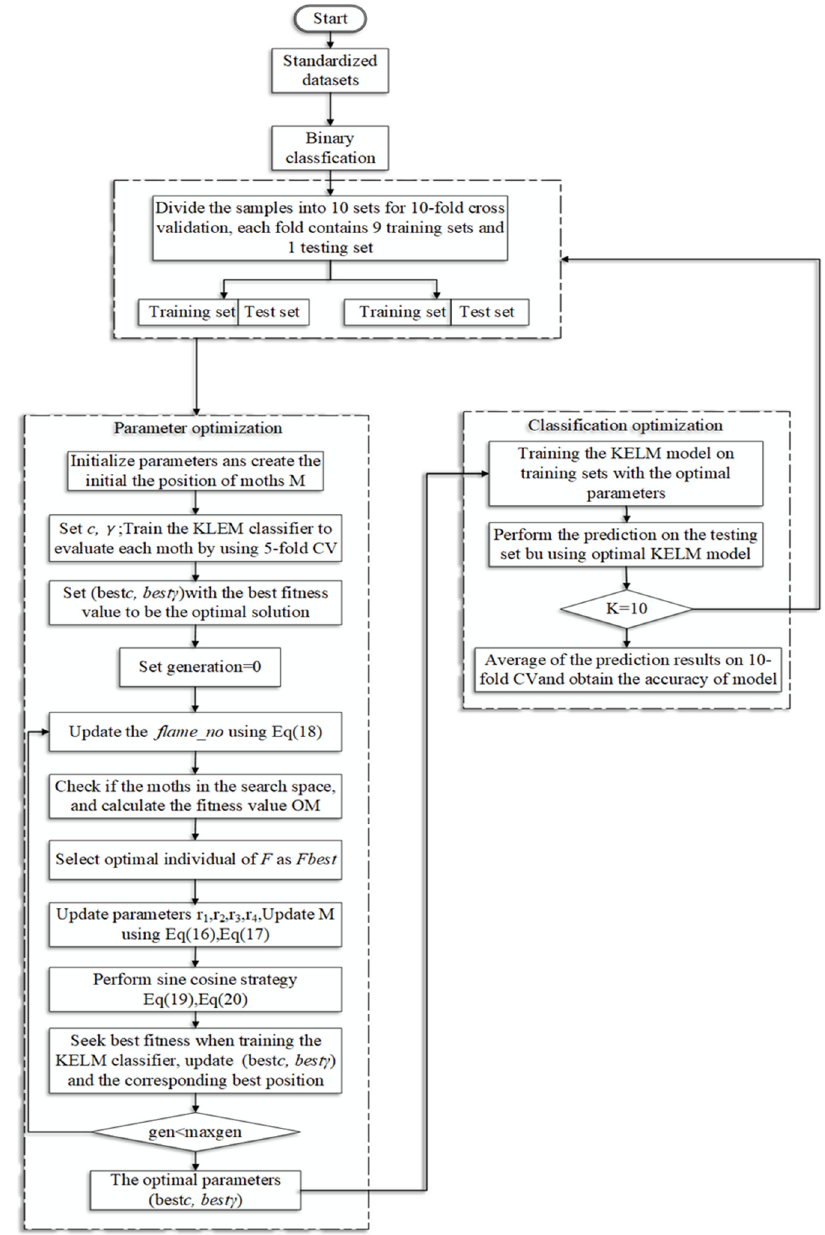
Figure 5. Soil erosion prediction model flowchart based on SMFO-KELM.